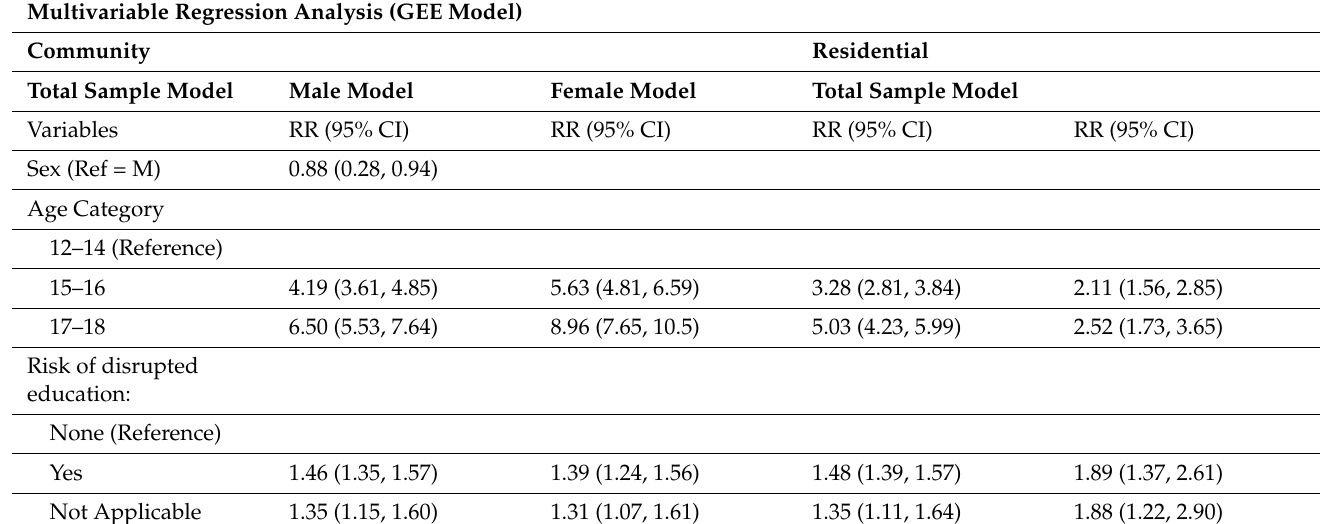
Table 5. Multivariable logistic regression using GEE examining factors associated with substance use among the community and residential settings by